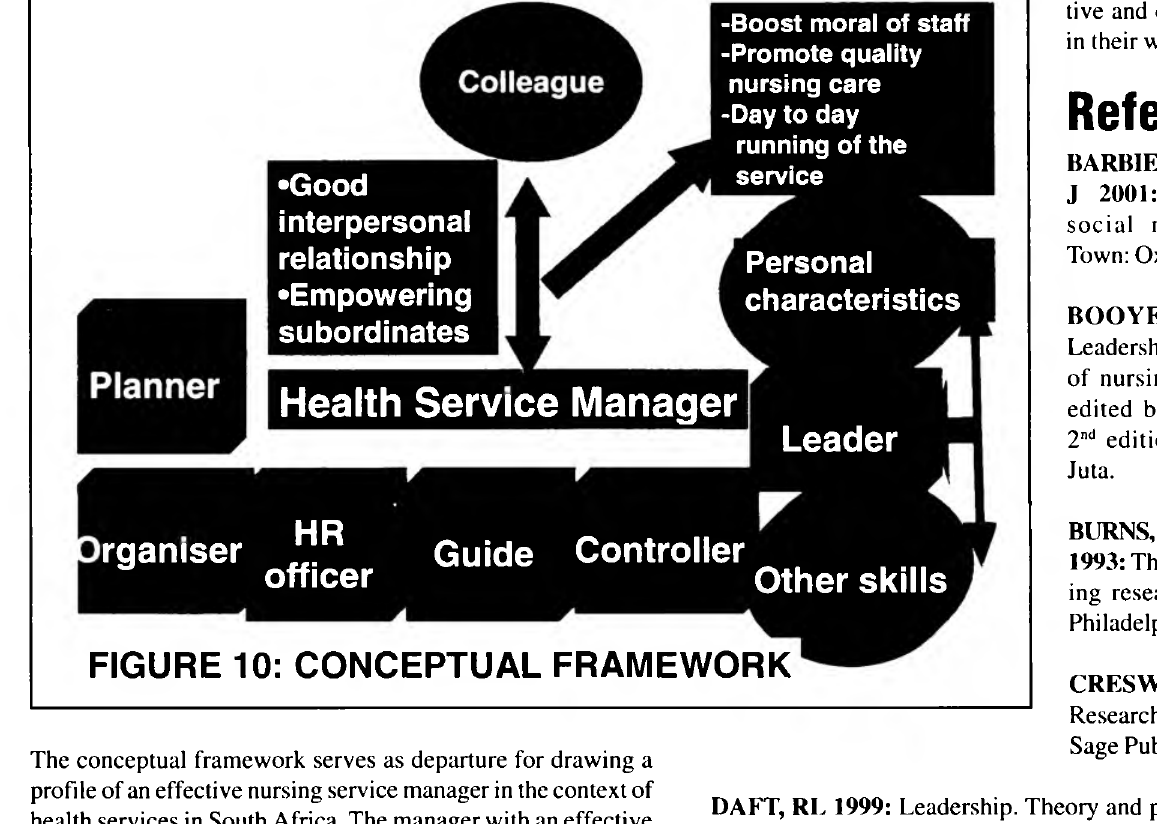
FIGURE 10: CONCEPTUAL